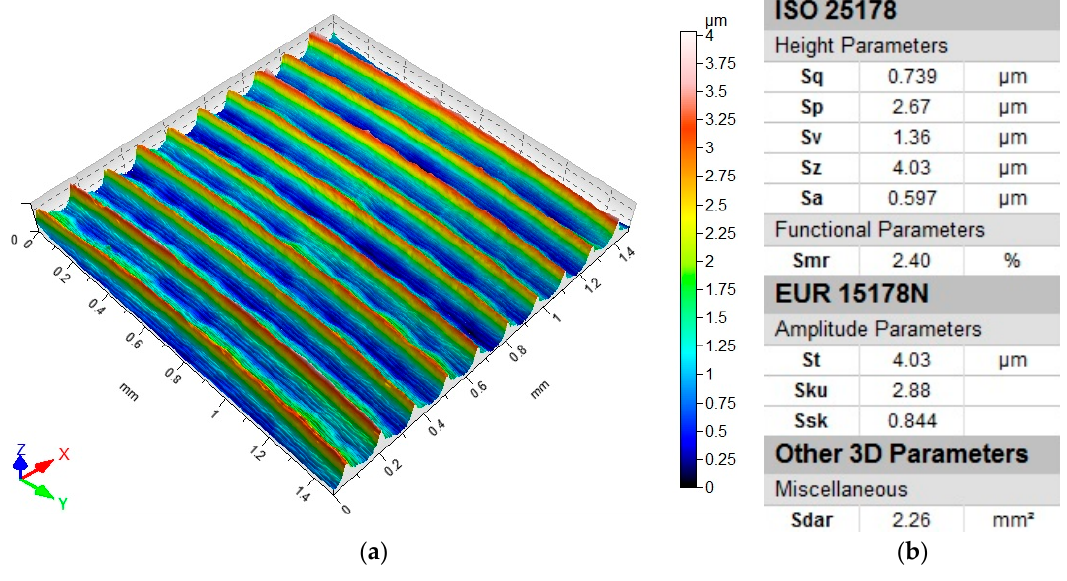
Figure 12. Roughness following milling: ( a ) topography; ( b ) parameters.